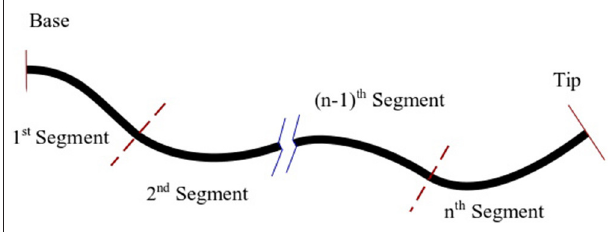
FIGURE 4 | A schematic of multi-backbone robot with multiple bending segments, dashed lines denote break